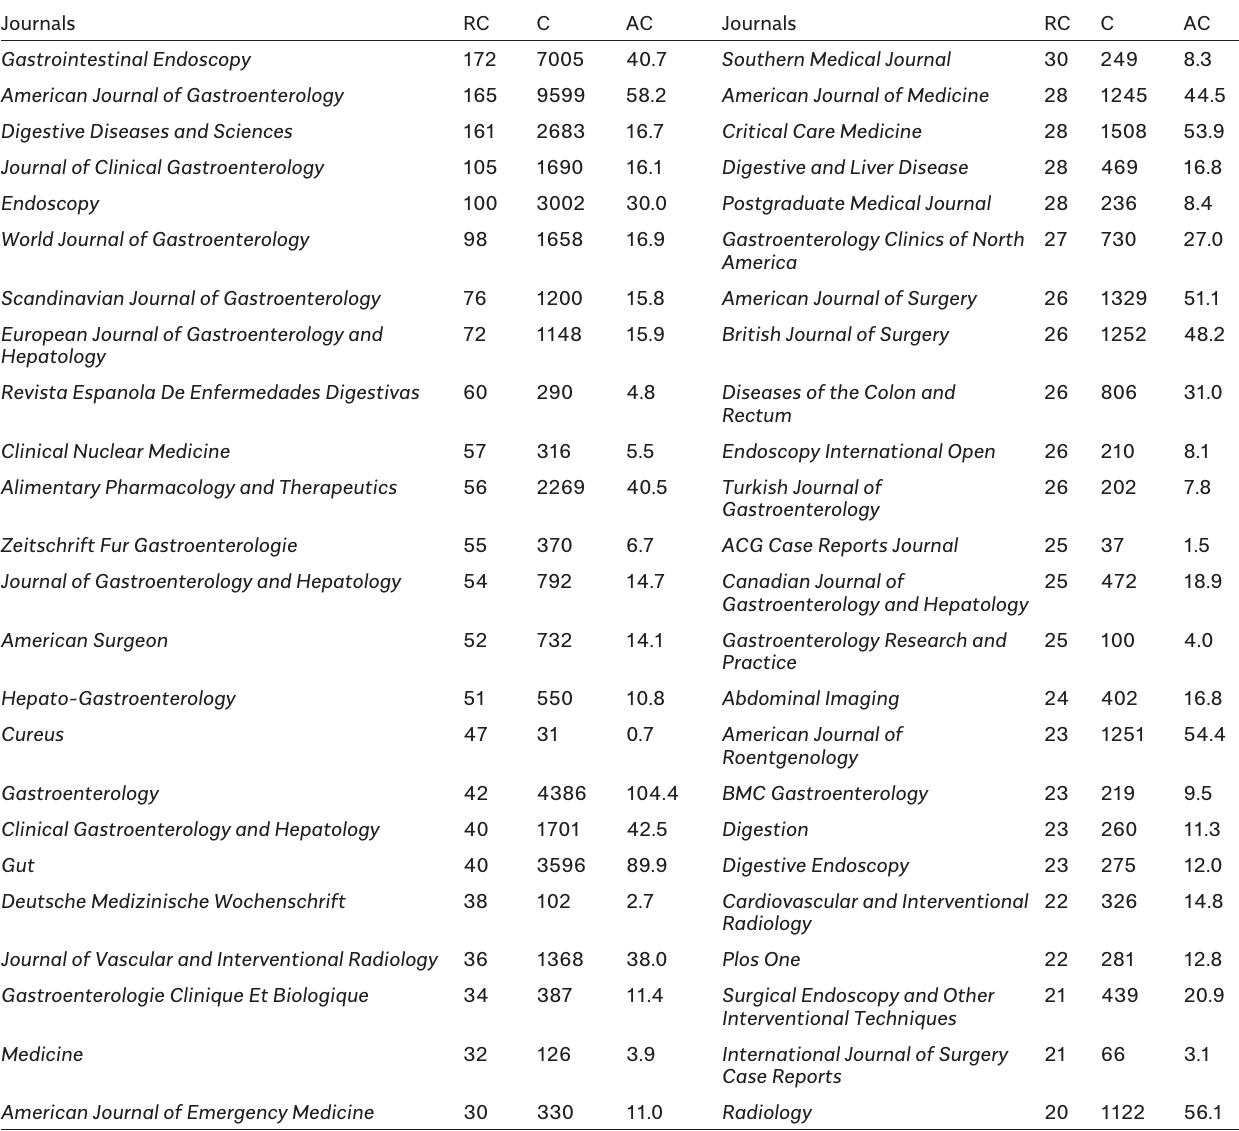
Table 1. Forty-Eight Most Active Journals with More Than 20 Articles on Gastrointestinal Bleeding Journals